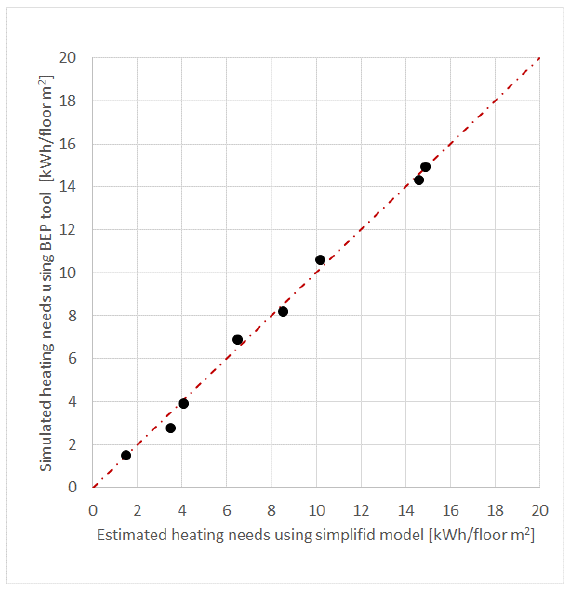
Figure 6. Comparison of the results of the detailed simulation of the case study and the application of